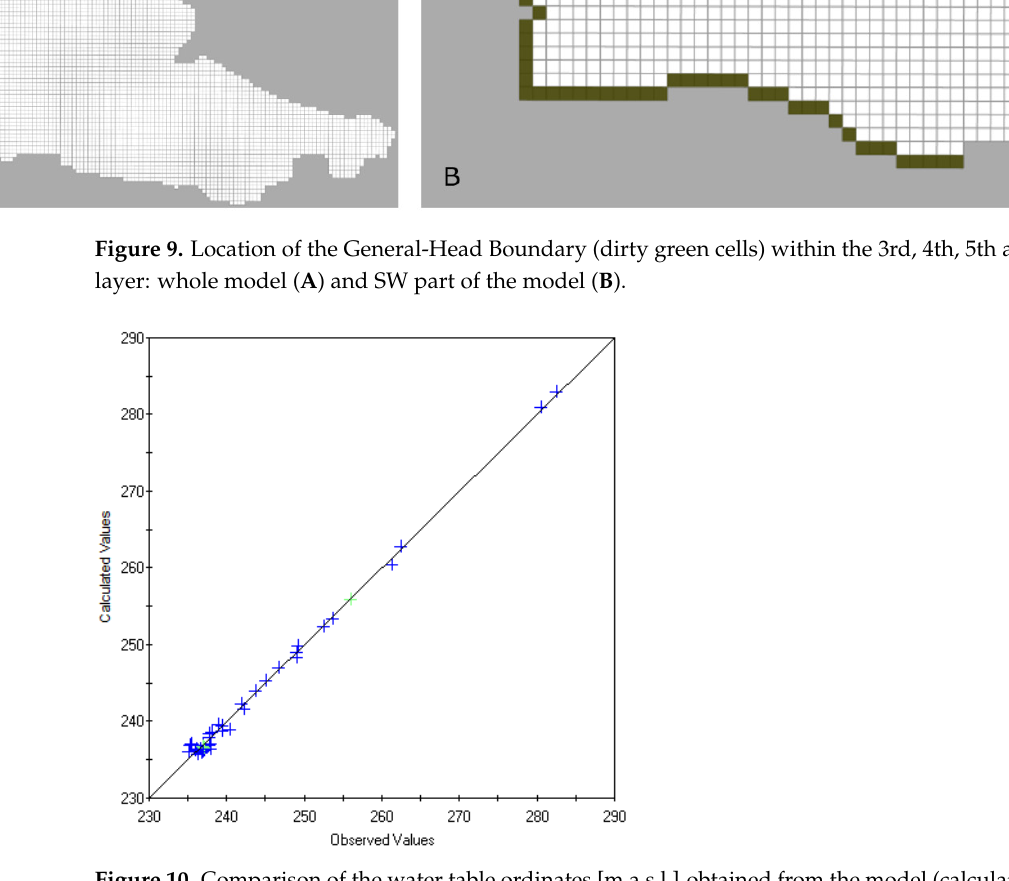
Figure 10. Comparison of the water table ordinates [m a.s.l.] obtained from the model (calculated values) and those observed in reality (observed values) for the adopted calibration points (blue—Middle Devonian, green—Quaternary).